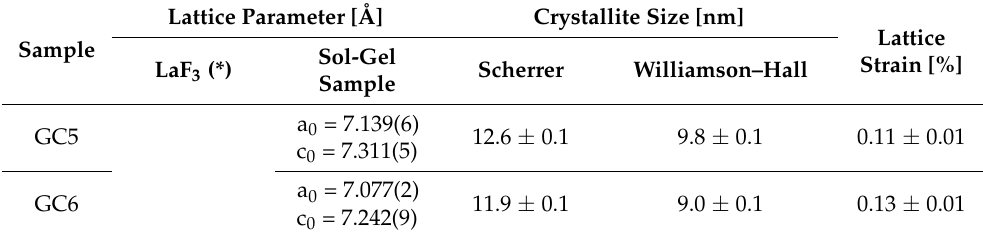
Figure 4. The photoluminescence emission (PL) spectra recorded for the series of prepared xerogels upon near-UV excitation at λ em = 352 nm.